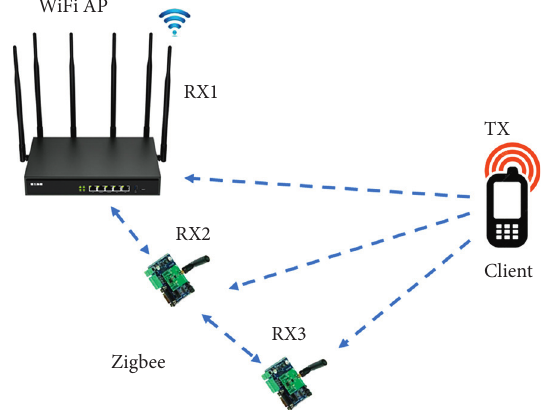
Figure 1: Heterogeneous wireless networks coexisting and